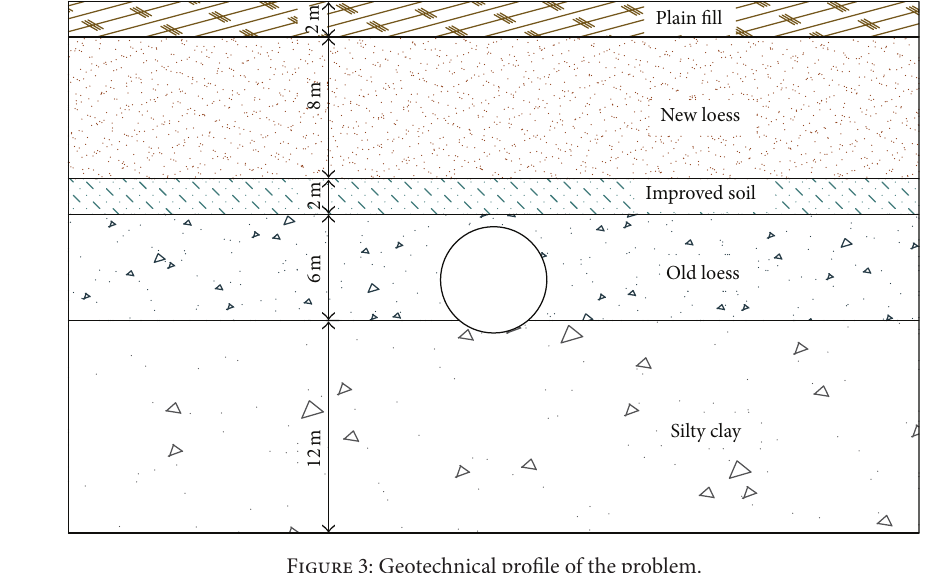
Figure 3: Geotechnical profile of the problem.